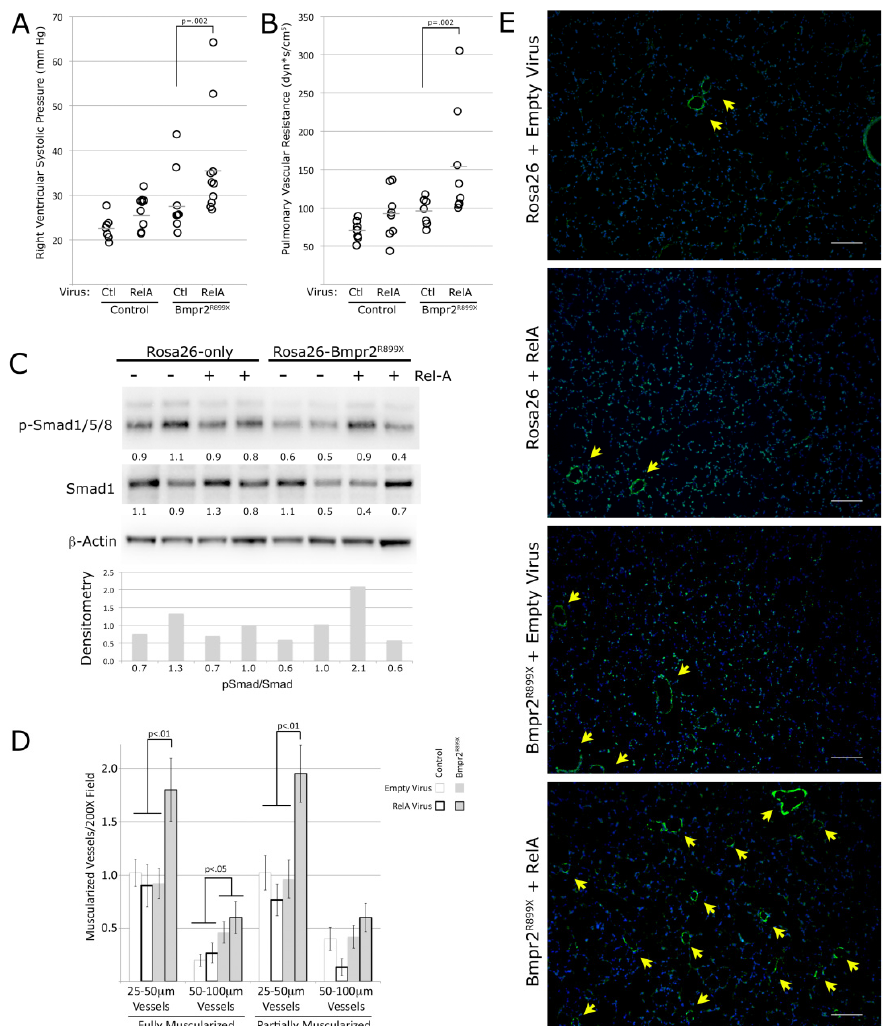
Figure 5. RelA virus exacerbates pulmonary arterial hypertension in Bmpr2 R899X mice. ( A ) By two-way ANOVA, Bmpr2 R899X genotype increased RVSP at p = 0.0042 and Rel-A virus increased RVSP at p = 0.03. Using non-parametric statistics (Wilcoxon) difference between groups is p = 0.0021, with rel-A causing a significant increase in RVSP in Bmpr2 R899X mice. Each circle corresponds to an individual mouse: grey bars are means. ( B ) By two-way ANOVA, Bmpr2 R899X genotype increased pulmonary vascular resistance (PVR) at p = 0.0078 and Rel-A virus increased RVSP at p = 0.0126. Using non-parametric statistics (Wilcoxon) difference between groups is p = 0.0020. ( C ) Neither Rel-A virus nor Bmpr2 R899X expression had a significant effect on Smad1 phosphorylation in whole mouse lung. By the time of sacrifice, though, Rel-A virus would have been cleared for at least a week. Numbers under each blot are densitometry normalized to beta-actin; the plot at bottom is phosphorylated normalized to total protein. ( D ) The mechanism of continuing increased RVSP resulting from Rel-A virus is likely through increased pulmonary vascular remodeling. There is a near doubling of partially and fully muscularized 25–50 m vessels in mutant mice receiving Rel-A virus. ( E ) Lung sections stained for smooth muscle actin (green) show a dramatic increase in muscularized small vessels (arrowheads) in Bmpr2 R899X expression mice receiving Rel-A